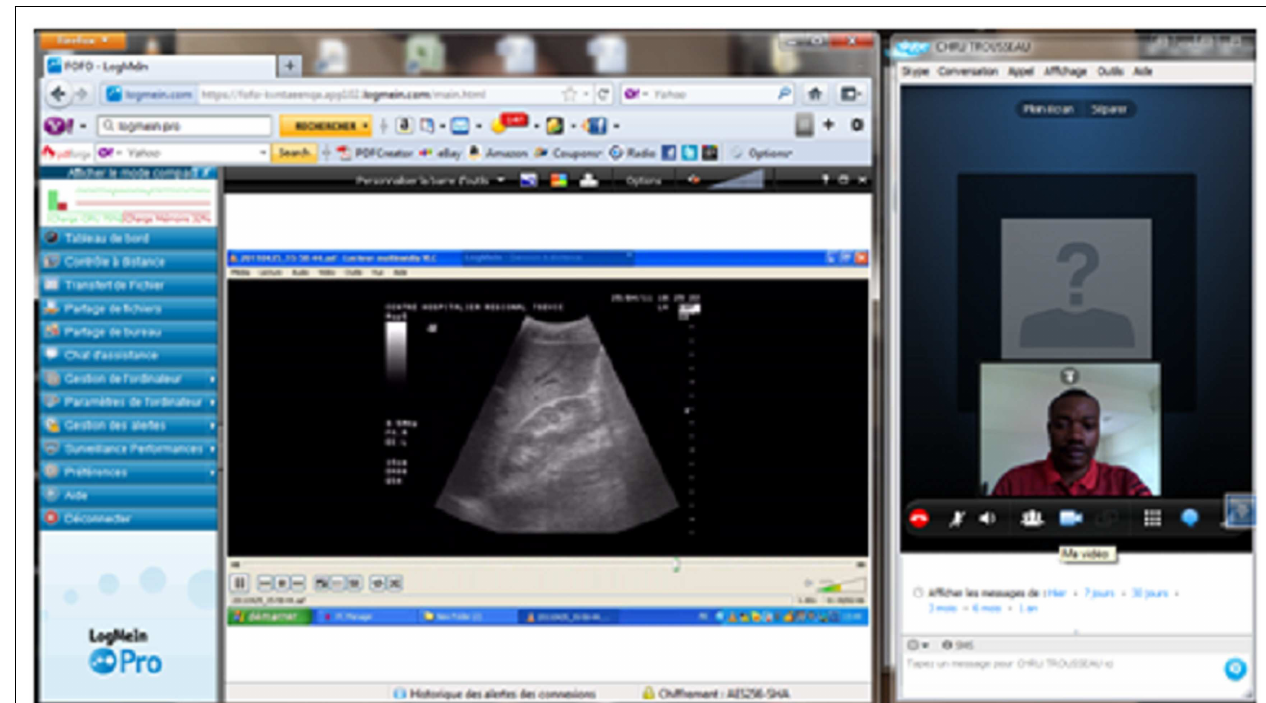
FIGURE 2 | Screen capture at the expert center during an abdominal ultrasound with LogMeIn .